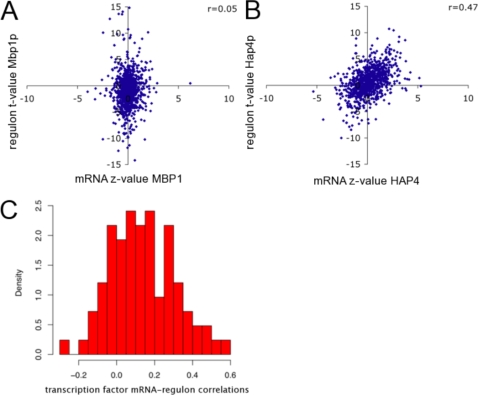
Relationship between mRNA expression level and regulatory activity of a TF.Shown are Pearson correlations between the normalized mRNA expression log-ratio and inferred activity (ChIP-based regulon) across all 936 expression profiles of (A) MBP1 (marginal correlation: r = 0.05; P = 0.14) and (B) HAP4 (strong correlation: r = 0.47; P<10−12). (B) Distribution of the correlations shown in part (a) and (b) over all 83 TFs analyzed.